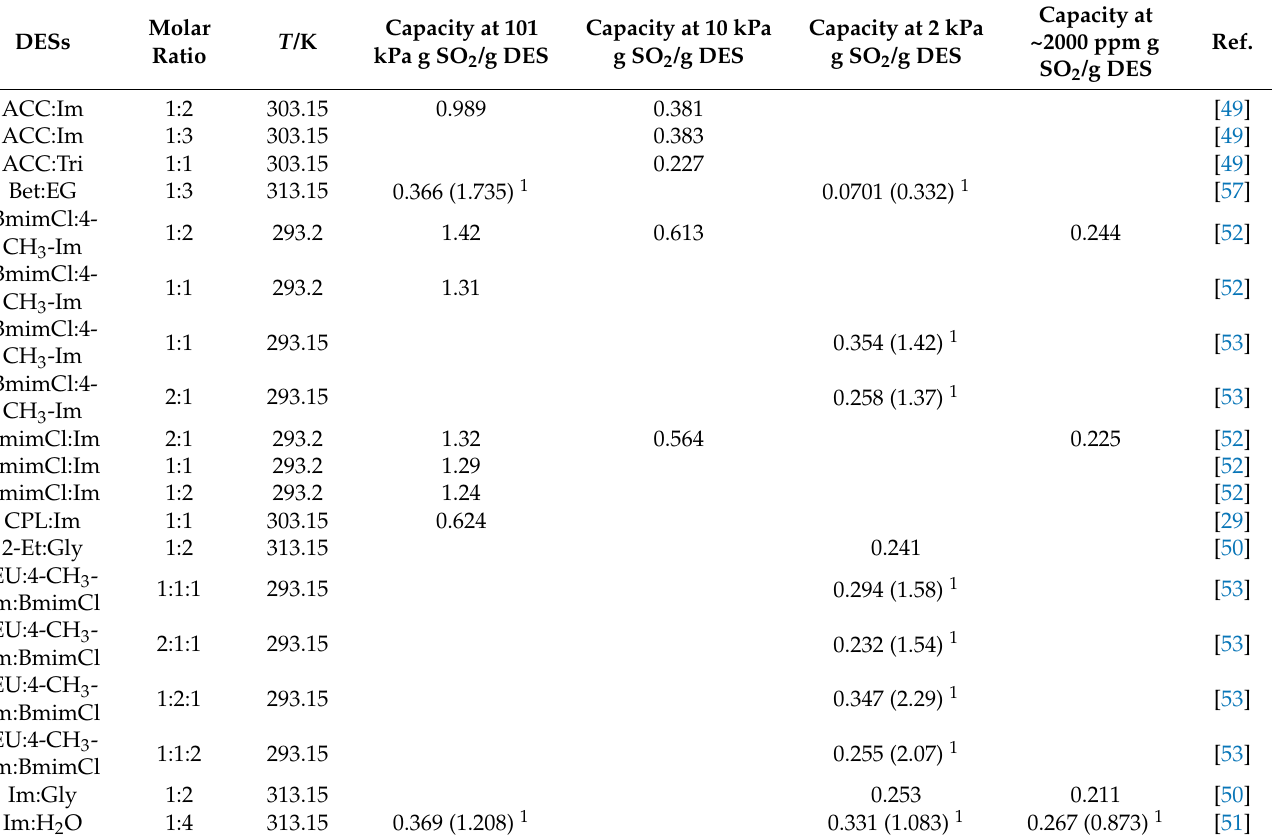
Table 2. SO 2 solubility in functionalized